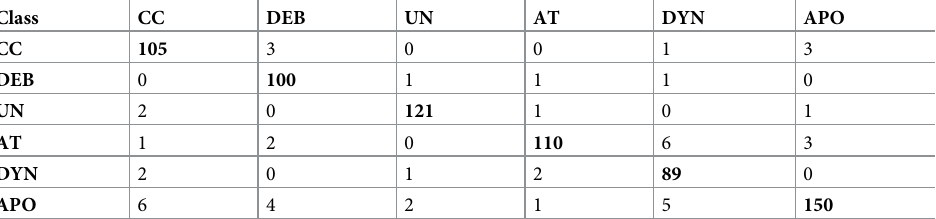
Table 11. Confusion matrix for the classification of the 724 real hESC images using the Fused CNN-Triplet archi- tecture of DeephESC 2.0. Class CC DEB UN AT DYN APO CC